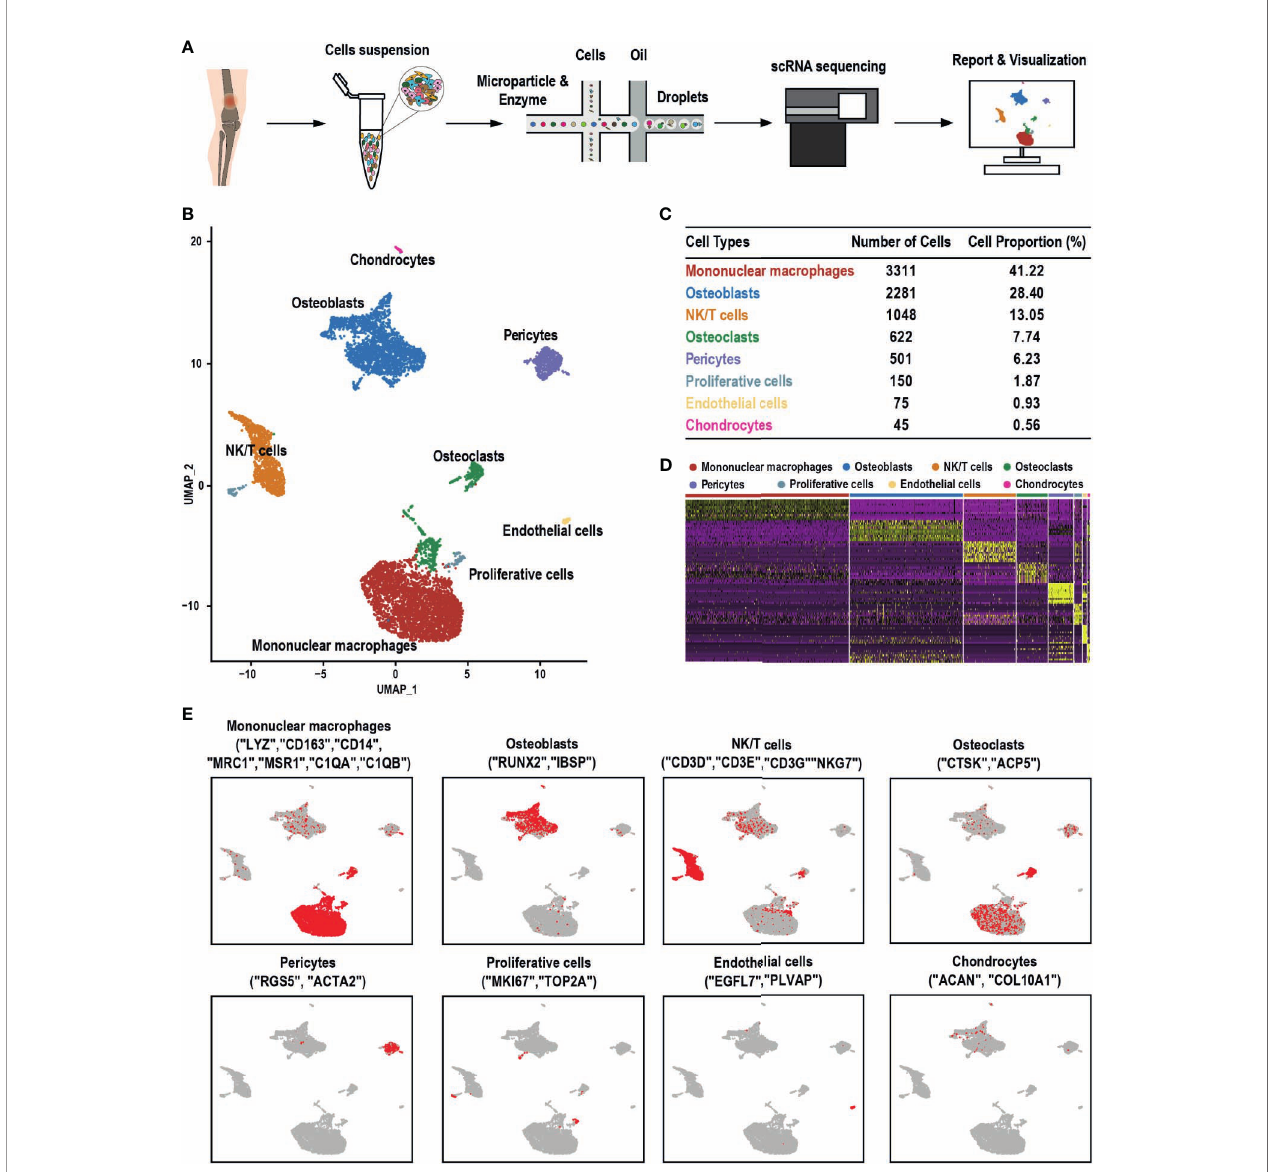
FIGURE 1 | scRNA-seq clustering analysis of GCTB. (A) Work fl ow depicting the collection and processing of GCTB tumor specimens for scRNA-seq. (B) UMAP plot of 8,033 cells demonstrating the eight main cell types in GCTB. (C) Cell number and percentage of the assigned cell types. (D) The heat-map shows and highlights the differentially expressed genes of each cluster. (E) UMAP plots show the expression of representative well-known markers across cell types in GCTB. scRNA-seq, single-cell RNA sequencing; GCTB, giant cell tumor of bone; UMAP, uniform manifold approximation and